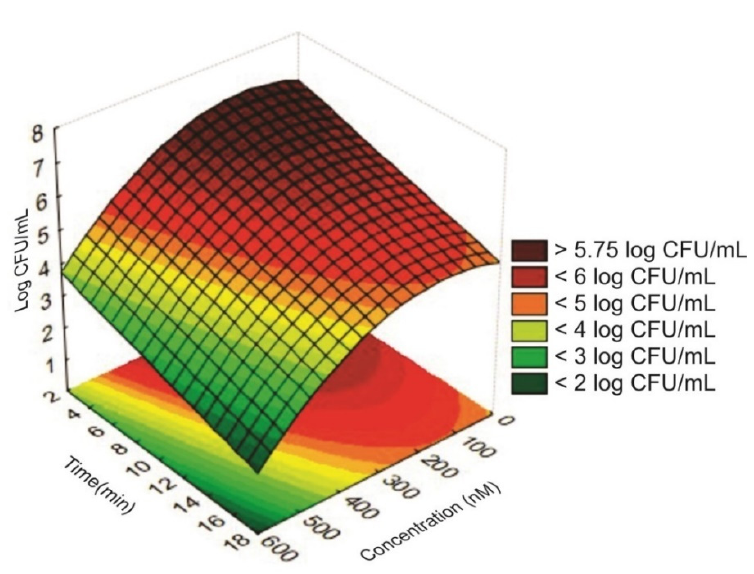
Figure 3. Response surface describing interactive influence of the photosensitizer (PS) concentration and irradiation time on S. aureus counts.